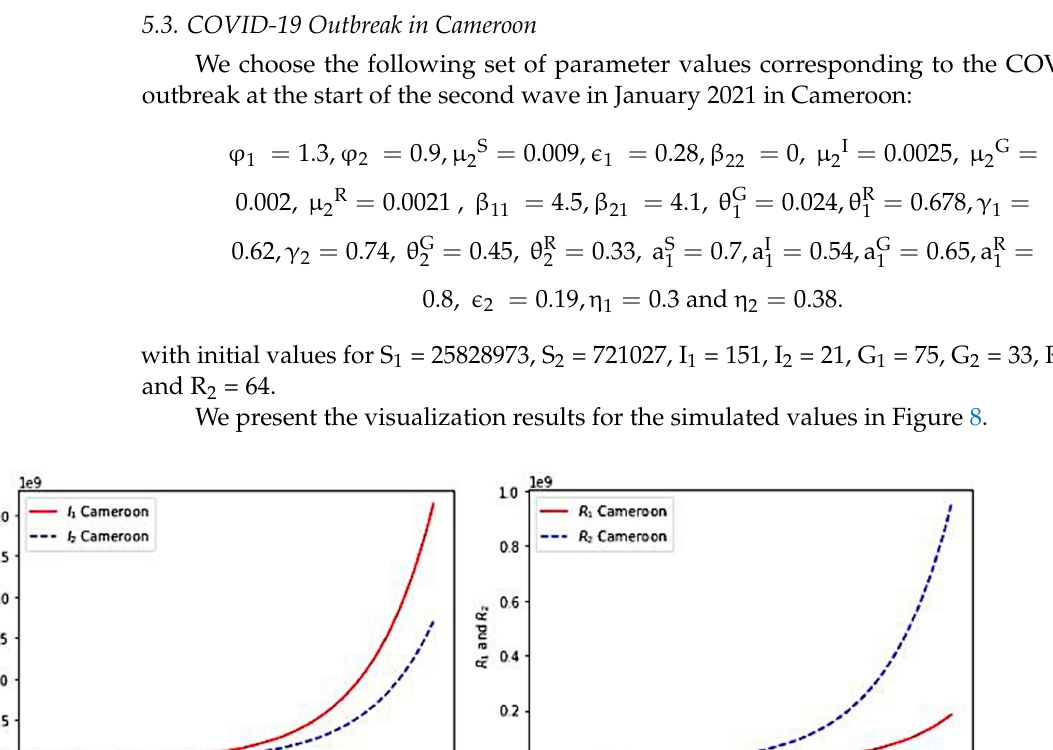
Figure 7. Numerical simulation of the variables I 1 and I 2 , R 1 and R 2 , G 1 and G 2 for France.